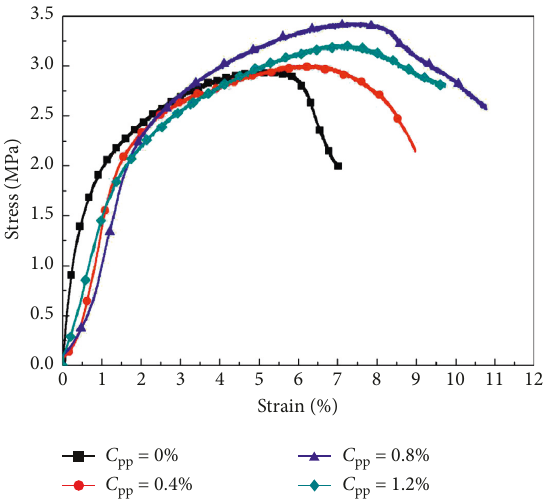
Figure 4: Static stress-strain curves of polypropylene fiber-rein- forced cement soil.